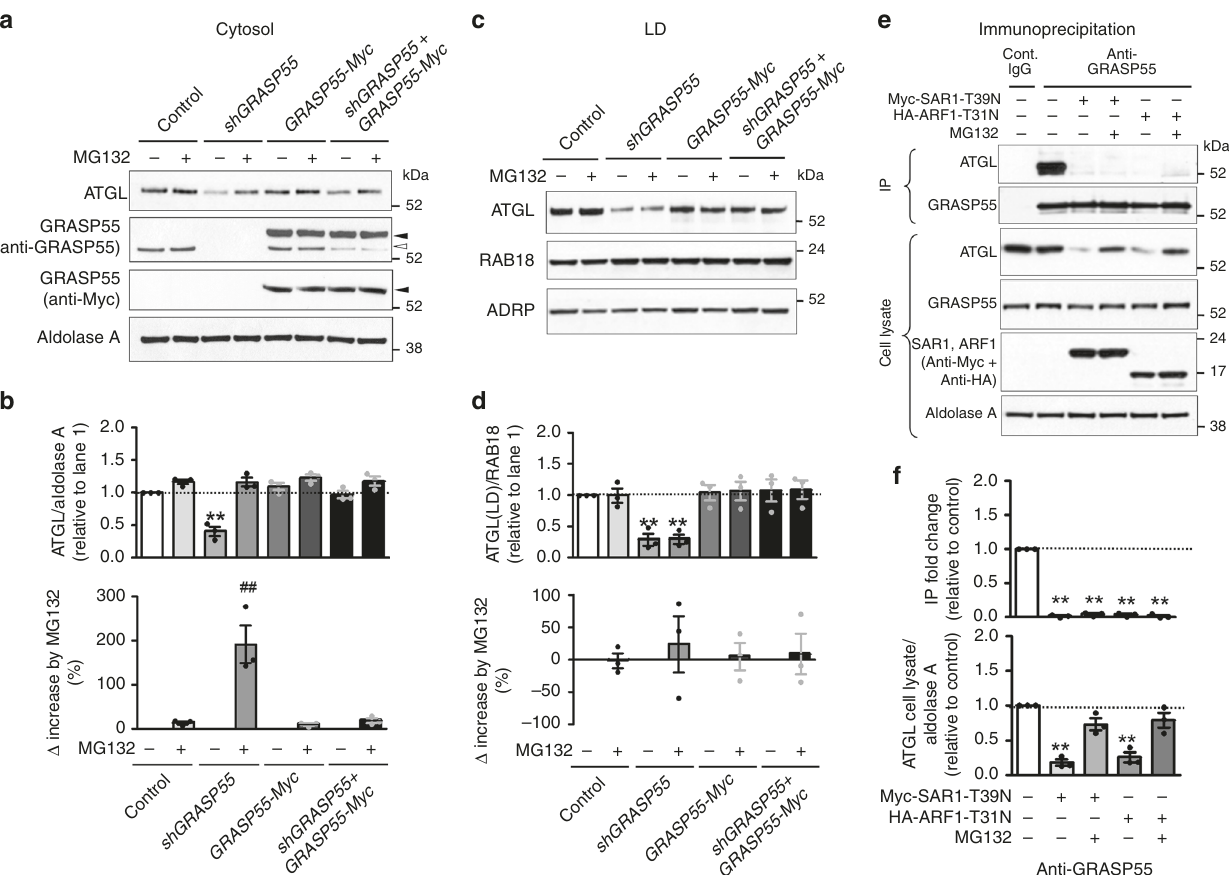
Fig. 8 Decreased ATGL levels in LDs by GRASP55 depletion are not reversed by proteasome inhibition. a – d Immunoblot analysis of ATGL levels in Caco-2 cells, in which GRASP55 was depleted ( shGRASP55 ) and/or exogenously supplemented ( GRASP55-Myc ). Cytosolic proteins were collected in the absence or presence of the proteasomal inhibitor MG132 (0.5 μ M, 16 h). For the induction of ATGL protein expression, cells were treated with 400 μ M oleic acid for 16 h. Representative immunoblots of cytosols and LDs are shown in ( a ) and ( c ), and the results of multiple experiments are summarized in ( b ) and ( d ), respectively ( n = 3 each). Aldolase A and RAB18/ADRP were used as loading controls for cytosolic and LD proteins, respectively. MG132 reversed the decreased cytosolic levels of ATGL by GRASP55 depletion, but did not signi fi cantly affect the ATGL levels in LDs. In contrast, the add-back of GRASP55 restored ATGL levels in both the cytosol and LDs. e , f Coimmunoprecipitation (IP) experiments with anti-GRASP55 antibodies were performed in Caco-2 cells. The ER-to-Golgi traf fi cking was blocked by dominant-inhibitory forms of SAR1 (SAR1-T39N) and ARF1 (ARF1-T31N). For the induction of ATGL protein expression, cells were treated with 400 μ M oleic acid for 16 h. A representative IP assay is shown in ( e ), and the results of multiple experiments are summarized in ( f , n = 3). Aldolase A was used as a cytosolic protein loading control. MG132 does not rescue the dissociation of GRASP55 and ATGL induced by SAR1-T39N and ARF1-T31N. Unprocessed blots can be found in Supplementary Fig. 22. Data are shown as mean ± SEM. ** p < 0.01, difference from control without MG132. ## p < 0.01, difference from control. All p values were calculated by ANOVA followed by Tukey ’ s multiple comparison tests. Source data are provided as a Source Data fi